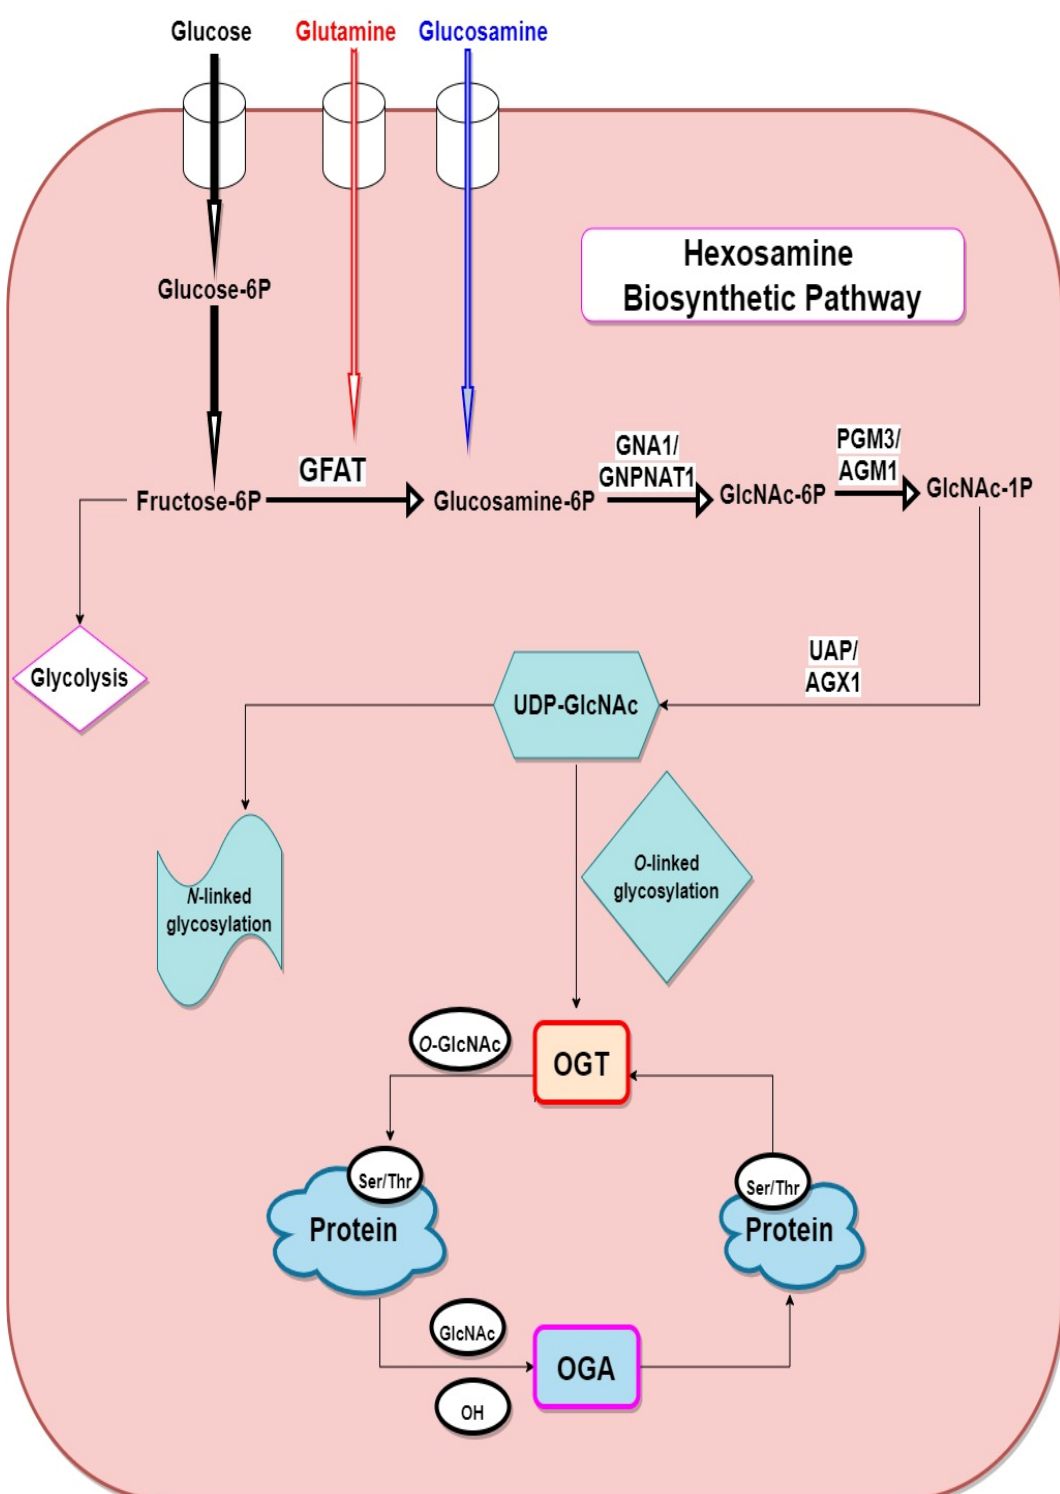
Figure 1. Schematic of the hexosamine biosynthetic pathway. fructose-6P (fructose-6-phosphate), glucosamine-6P (glucosamine-6-phosphate), GFAT (glutamine:fructose-6-phosphate amidotrans- ferase), OGT ( O -GlcNAc transferase), OGA ( O -GlcNAcase) GNA1/GNPNAT1 (glucosamine-6- phosphate N -acetyltransferase), GlcNAc-6P ( N -acetylglucosamine-6-Phosphate), GlcNAc-1P ( N - acetylglucosamine-1-phosphate), PGM3/AGM1 (phosphoglucomutase), UDP-GlcNAc (uridine di- phosphate- N -acetylglucosamine), UAP/AGX1 (UDP- N -acetylhexosamine pyrophosphorylase).